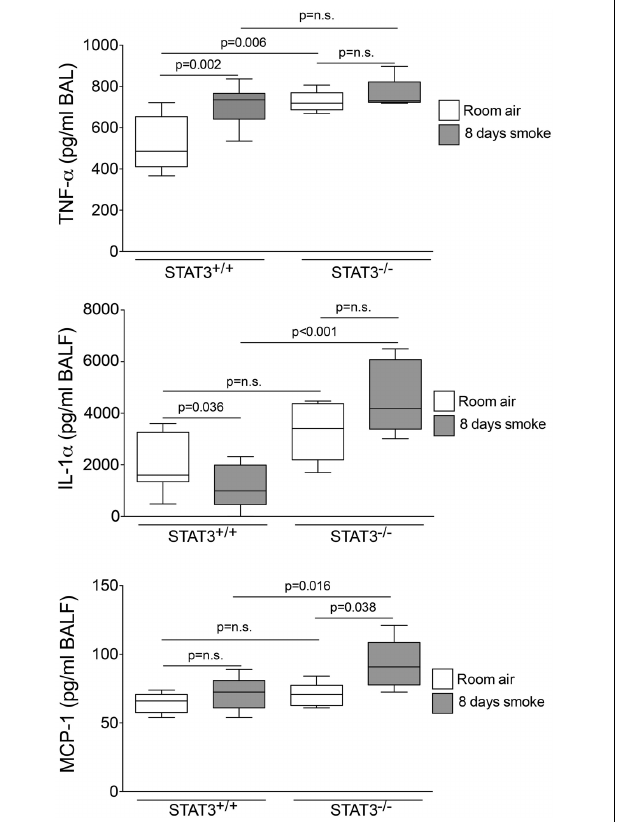
FIGURE 3 | STAT3 expression suppresses TNF- α , IL-1 α , and MCP-1 BALF protein levels. Bioplex assays measured BALF cytokines in room air and 8-day smoke-exposed STAT3 + / + and STAT3 − / − mice. Data are reported as cytokine level (pg/ml). Plots show range and average ± S.E.M. N = 10 in each group. p values shown, comparing both treatments connected by a line. n.s. denotes no significant difference between